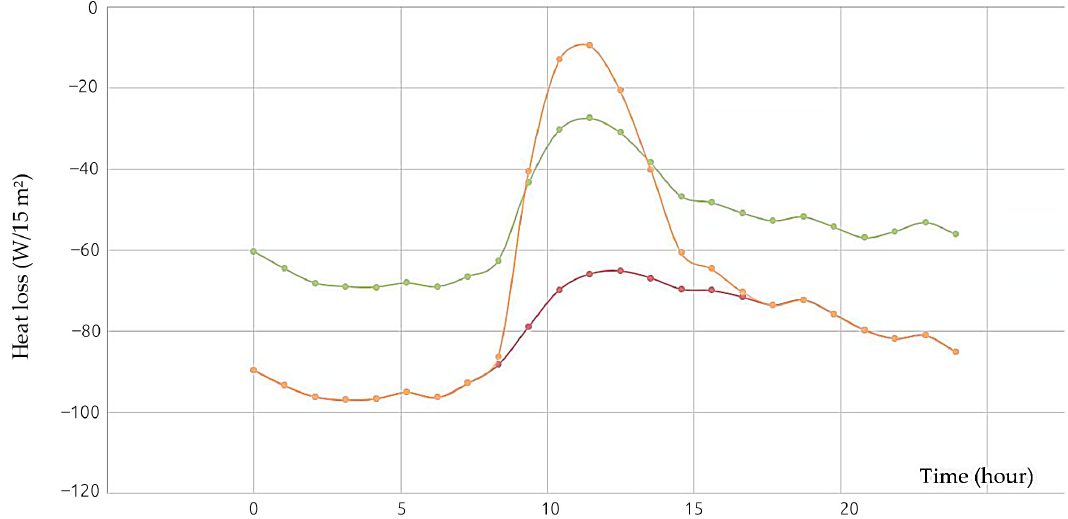
Figure 5. Example of simulated course of airflow from interior to exterior and their comparison as of 21 January 2022 for dimension of a southeast façade strip of 15 m height and 1 bm width. Façade with traditional contact insulation system (green), façade without air flow control through a ventilated gap (red) and smart façade with airflow control through a ventilated gap (orange).